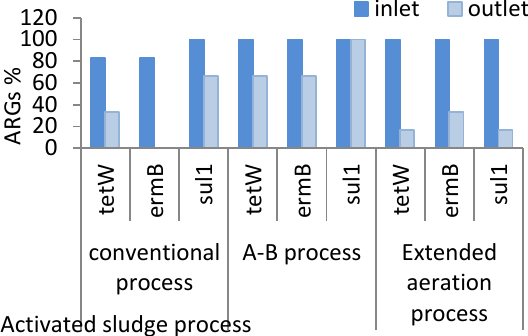
Figure 3. Percentage of antibiotic resistance genes (ARGs) in inlet and outlet of different activated sludge processes